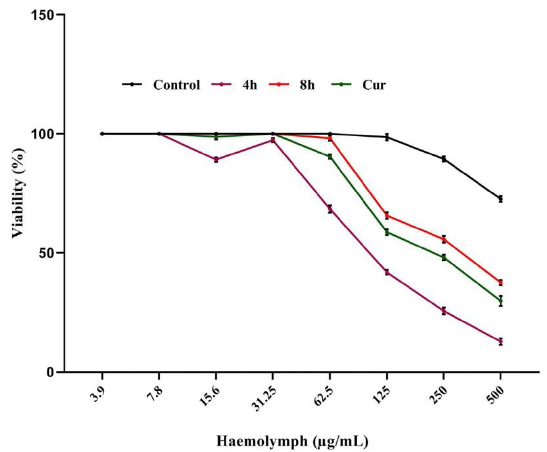
Figure 2. The viability of control and curcumin-injected M. domestica larval hemolymph on MCF-7 cell lines using the MTT assay. The incubation with serial concentrations (3.9–500 µ g/mL) of the tested larval hemolymphswasperformedintriplicate. Datawereillustratedas(mean ± SD)ofthreeseparateexperiments. Molecules 2022 , 27 , x FOR PEER REVIEW